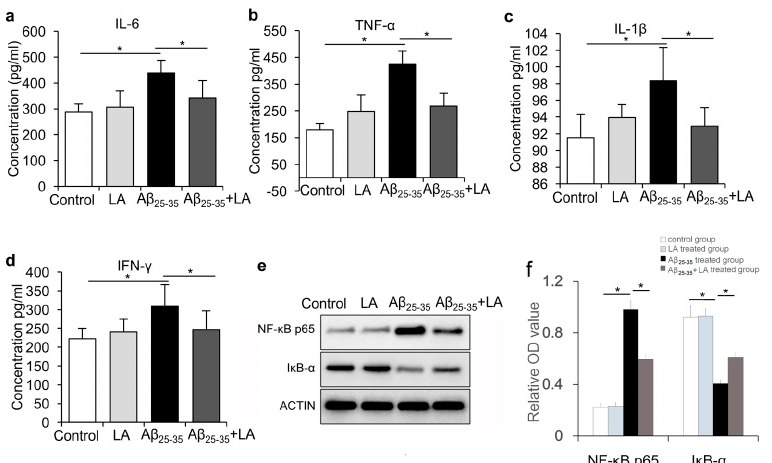
Figure 4. 100 μ mol/L α -lipoic acid (LA) inhibited the expression of inflammatory factors induced by 25 μ mol/L A β 25–35 . ( a – d ) The levels of medium IL-6, IL-1 β , TNF- α , and IFN- γ were measured using ELISA. ( e ) The relative expressions of NF- κ B p65 and I κ B- α were measured using Western blot after BV2 cells were treated with 100 μ mol/L LA and/or 25 μ mol/L A β 25–35 . ( f ) Statistical result of the protein expression in Western blot from e. The data are presented as the mean ± SD of three inde- pendently performed experiments. * p < 0.05. Inducible nitric oxide synthase (iNOS) is an important catalytic enzyme in organisms, which plays a biological role by catalyzing the production of nitric oxide (NO) by the sub- strate arginine. Innumerable studies have shown that iNOS is closely related to inflam- mation, and bacteria, viruses, and a variety of inflammatory factors can induce its expres- sion to produce endogenous NO, which, in turn, plays an important biological role. There- fore, we next measured nitric oxide (NO) and inducible nitric oxide synthase (iNOS) levels in BV2 cells after A β 25–35 treatment and found that NO and iNOS were increased. When we added LA to BV2 cells before A β 25–35 treatment, the levels of NO and iNOS induced by A β 25–35 treatment were repressed (Figure 5a,b). Figure 5. α -lipoic acid (LA) inhibited the increased level of NO and iNOS induced by A β 25–35 . ( a ) Statistical analysis of the release of NO after LA and/or A β 25–35 treatment. ( b ) ELISA was performed to detect the activity of iNOS in BV2 cells. The data are presented as the mean ± SD of three inde- pendently performed experiments. * p < 0.05.